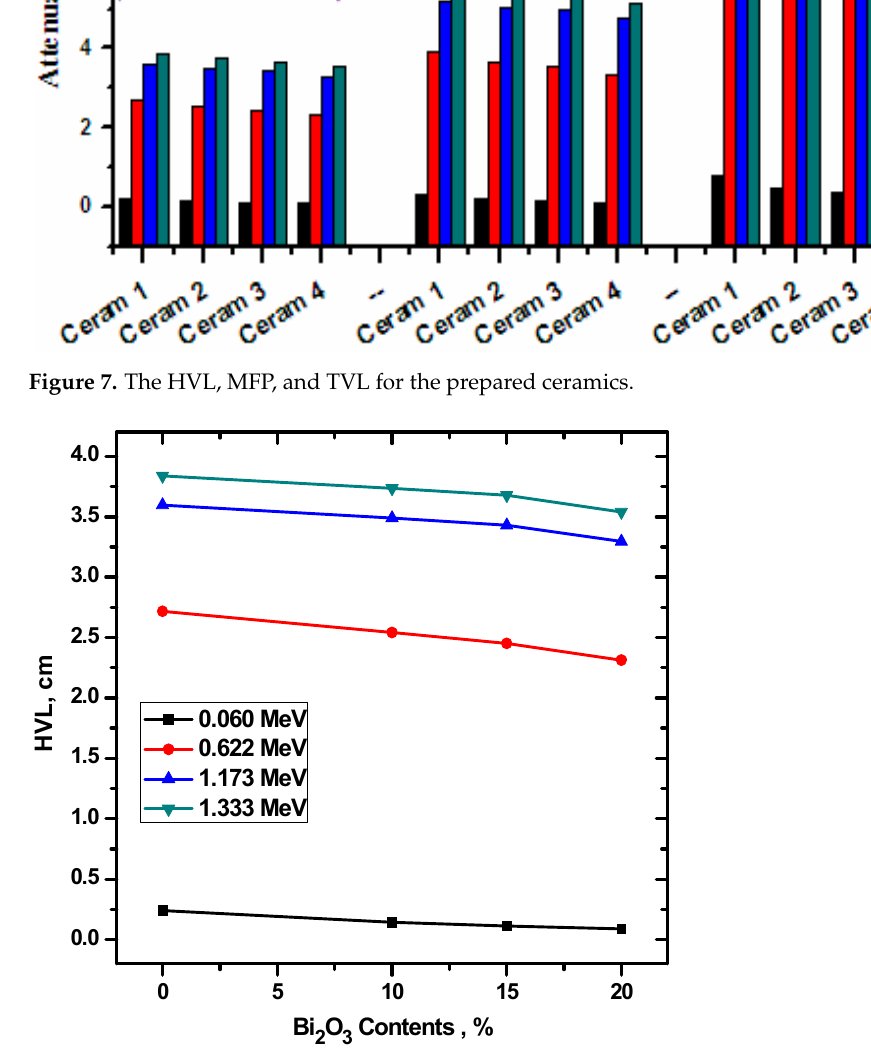
Figure 8. The HVL for the prepared ceramics as a function of Bi 2 O 3 . Figure 10 graphs the LAC of the four ceramic samples, as well as four other radiation shielding materials, at two chosen energies, 0.060 MeV and 0.662 MeV. The other four materials added for comparison are granite and marble [38], two other common materials, and Kaolin + 30% micro Bi 2 O 3 and Kaolin + 30% nano Bi 2 O 3 [39], which have been previously tested and proposed as shielding materials. At both energies, granite and marble have the lowest LAC values, while Ceram 2–4 have the greatest LAC